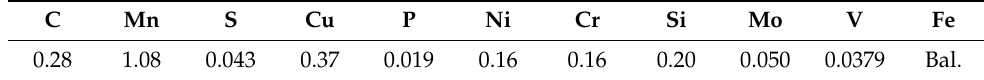
Table 1. CS elemental composition in